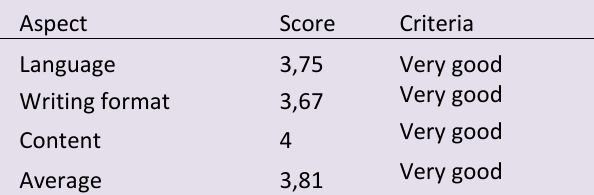
Table 8 . Product Validation